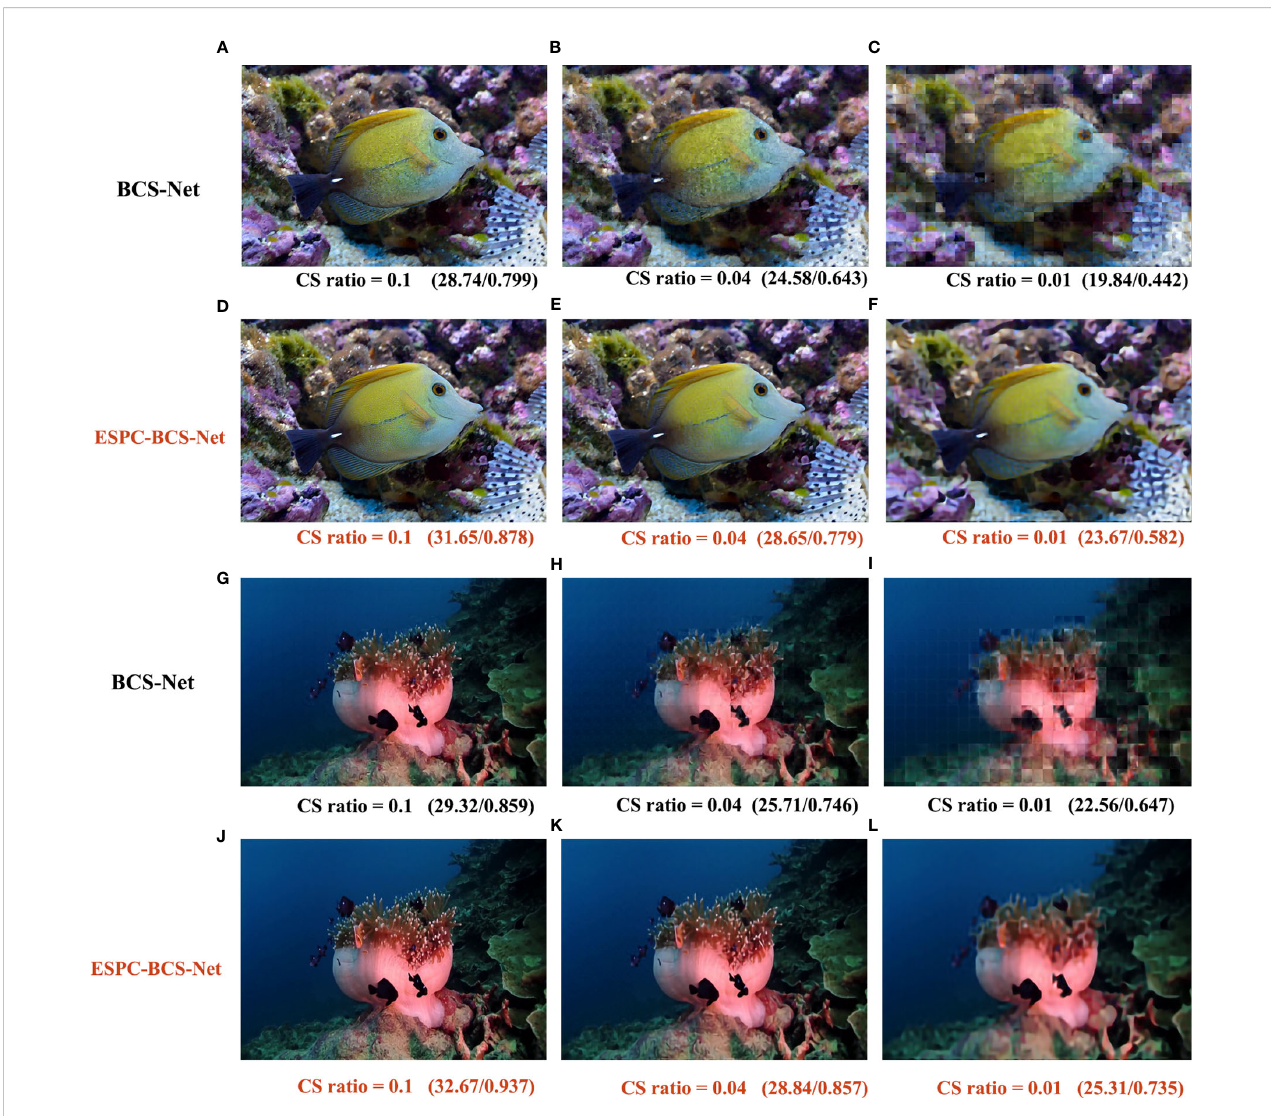
FIGURE 3 Visual comparison of BCS-Net and ESPC-BCS-Net. We evaluate the reconstructed underwater images by PSNR/SSIM. The size of (A-F) is 1024×678, and the size of (G-L) is 960×540.